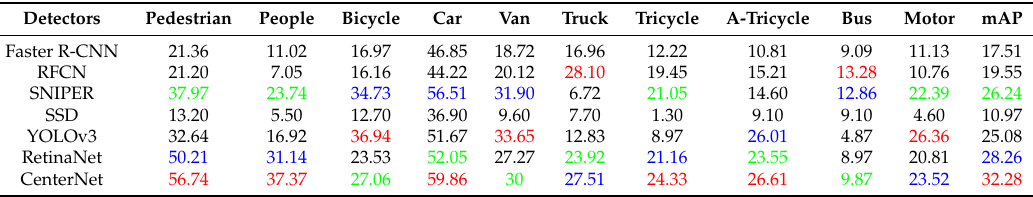
Table 4. The AP (IoU = 0.50) scores on the VisDrone2019 Validation set of each object category. The top three results are highlighted in red, blue and green